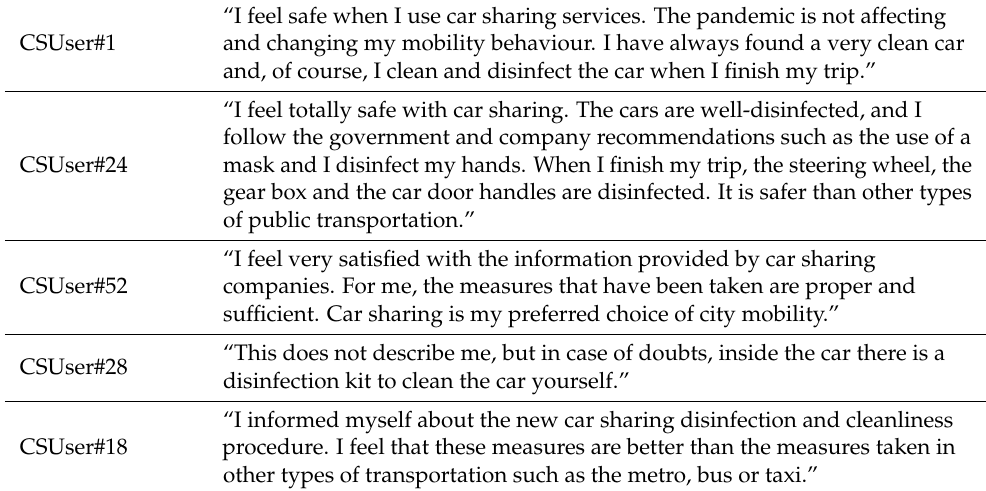
Table 5. Enthusiast profile